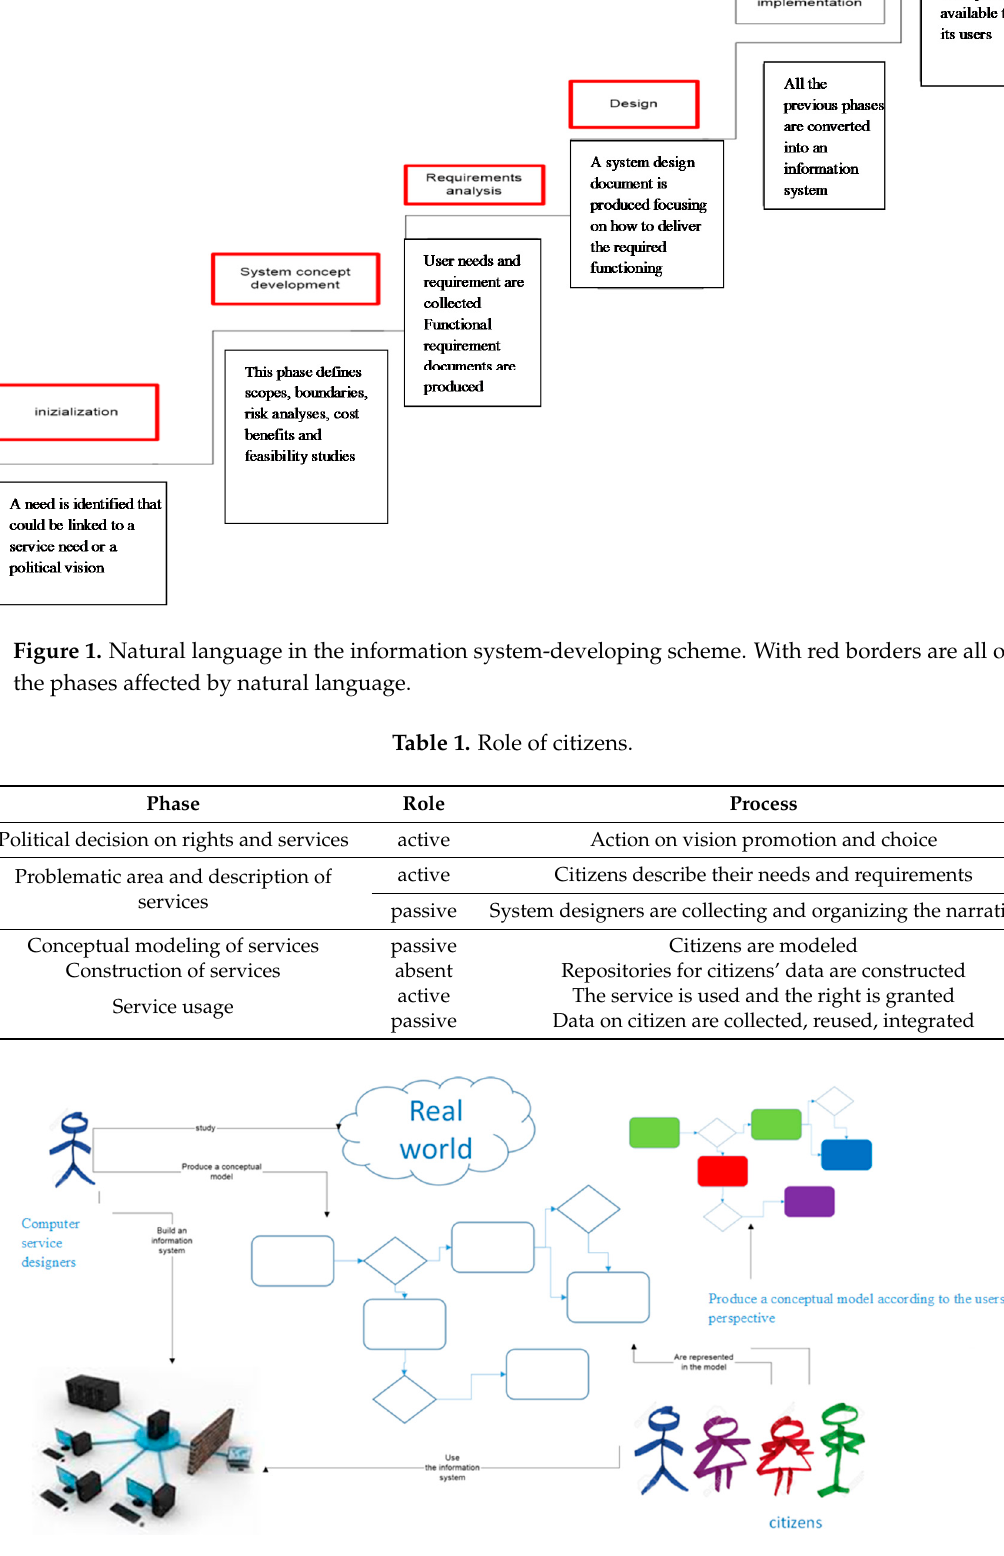
Figure 2. Smart services conceptual models as per the users’ perspective.